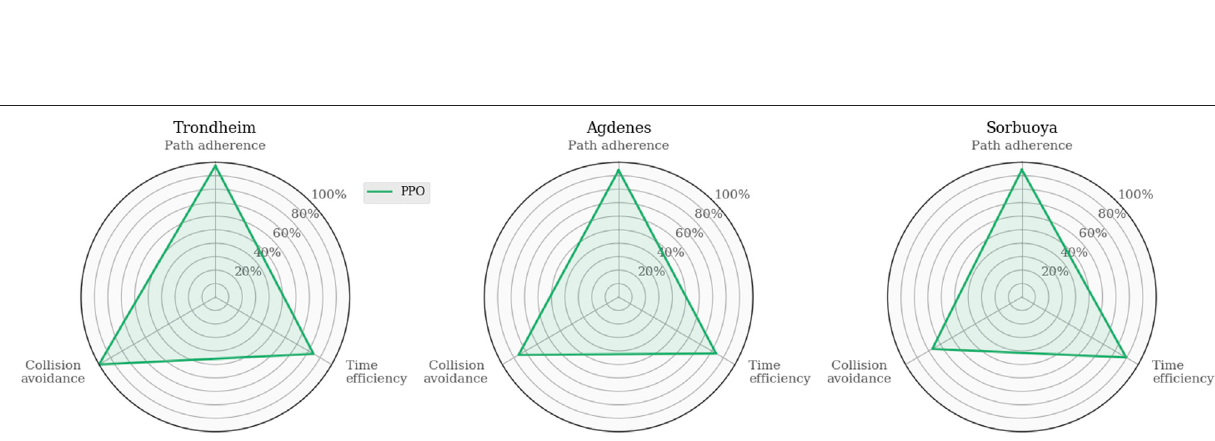
Frontiers in Robotics and AI |